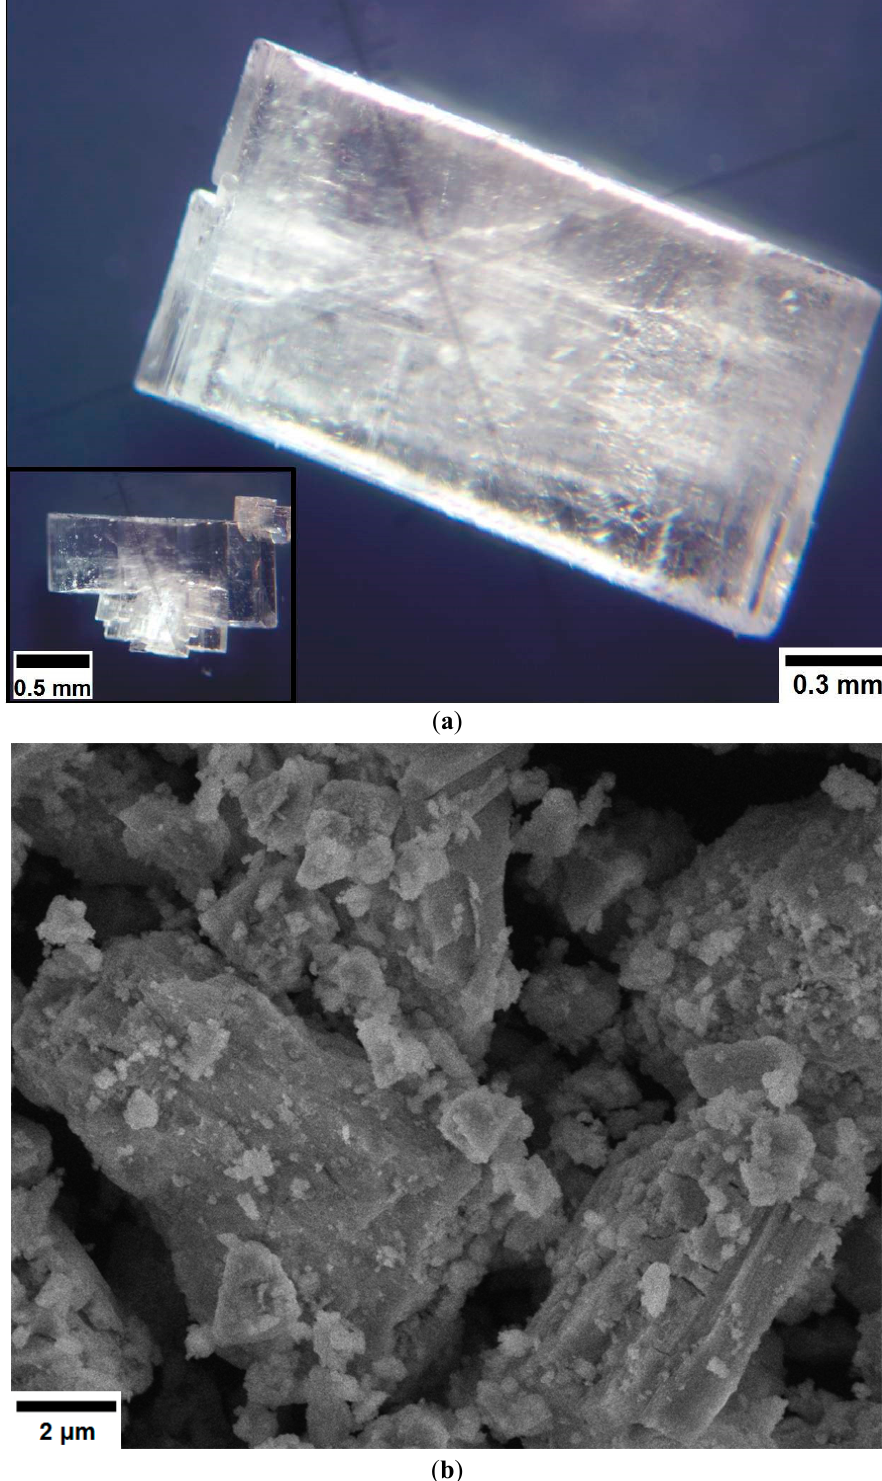
Figure 1. ( a ) Photo images of selected [CsEu(H 2 O) 3 (SO 4 ) 2 ]·H 2 O crystals and ( b ) an SEM pattern of the CsEu(SO 4 ) 2 powder.